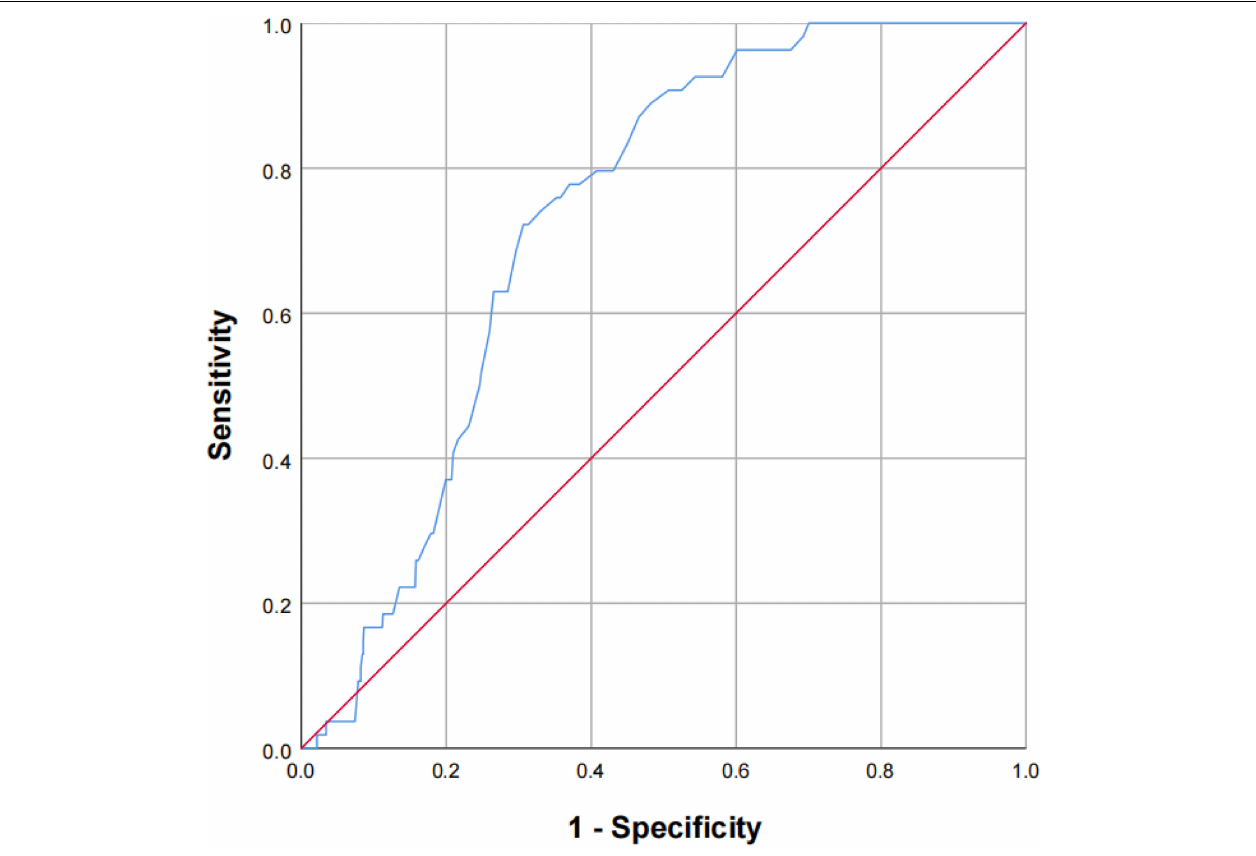
FIGURE 3 | The capability of Cys-C to identify the patients of OSA with a high risk of stroke. Receiver-operating characteristic curve showed the performance of Cys-C in predicting a high risk of stroke. The AUC was 0.731 (95% CI: 0.683–0.779, P = 0.001). AUC: area under the receiver operating characteristic curve; Cys-C: cystatin C; CI: confidence interval. TABLE 3 | Subgroup analysis of the associations between Cys-C and incidence of stroke. Quartile 1 Quartile 2 Quartile 3 Quartile